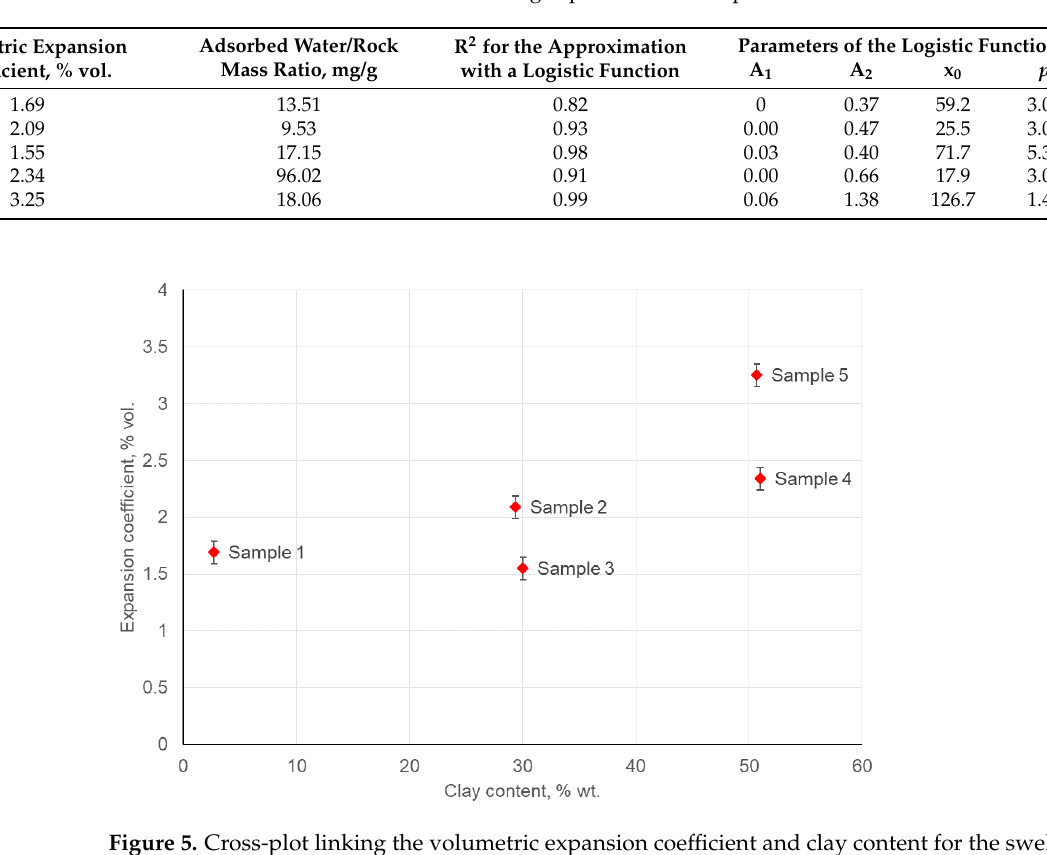
Figure 5. Cross-plot linking the volumetric expansion coefficient and clay content for the swelling experiments with 0.2% wt. NaOH.